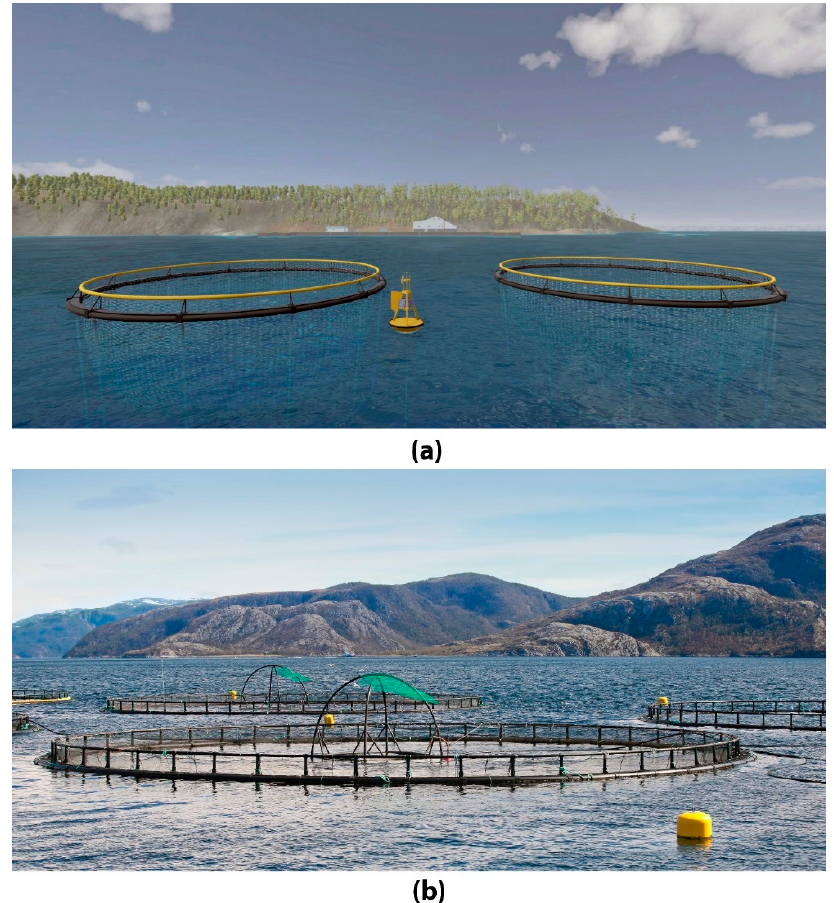
Figure 2. ( a ) View of the virtual inspection site, and ( b ) a real fish farm site for reference purposes.